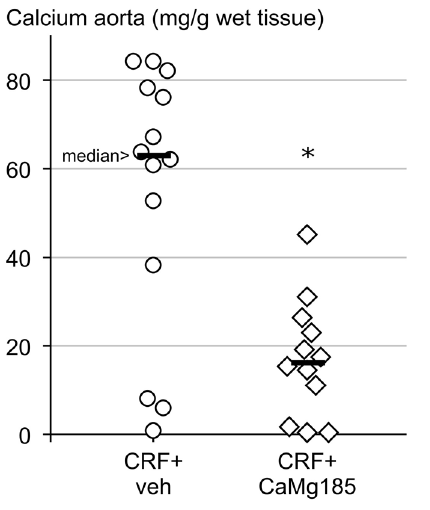
Figure 2. Aortic calcification in vehicle versus 185 mg/kg CaMg treated chronic renal failure (CRF) rats. *: p , 0.05 vs. CRF +